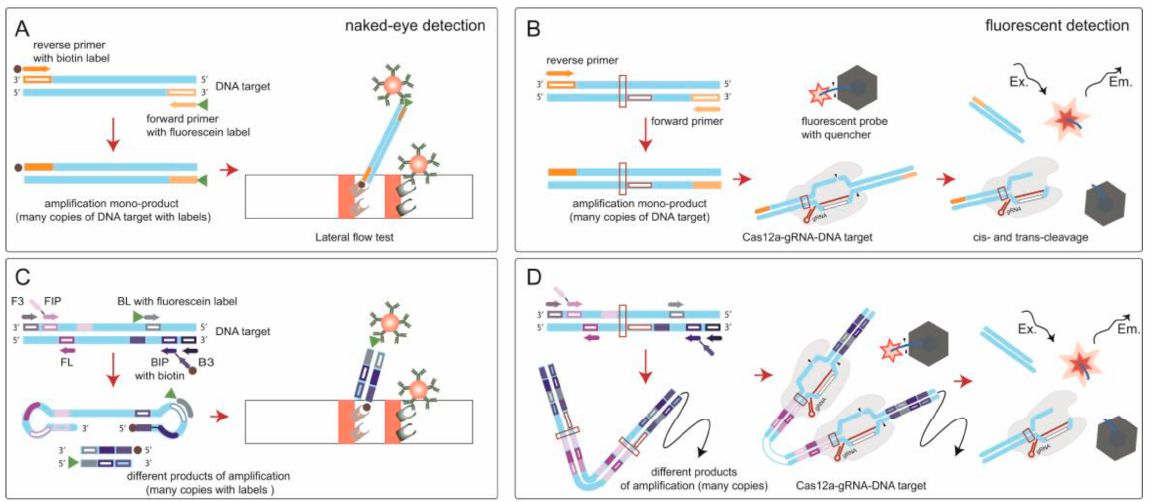
Figure 1. Schemes of the biosensing techniques with isothermal amplifications compared in this study using the example of E. amylovora detection: ( A ) RPA-LFT; ( B ) RPA-CRISPR/Cas; ( C ) LAMP-LFT; and ( D ) LAMP-CRISPR/Cas.